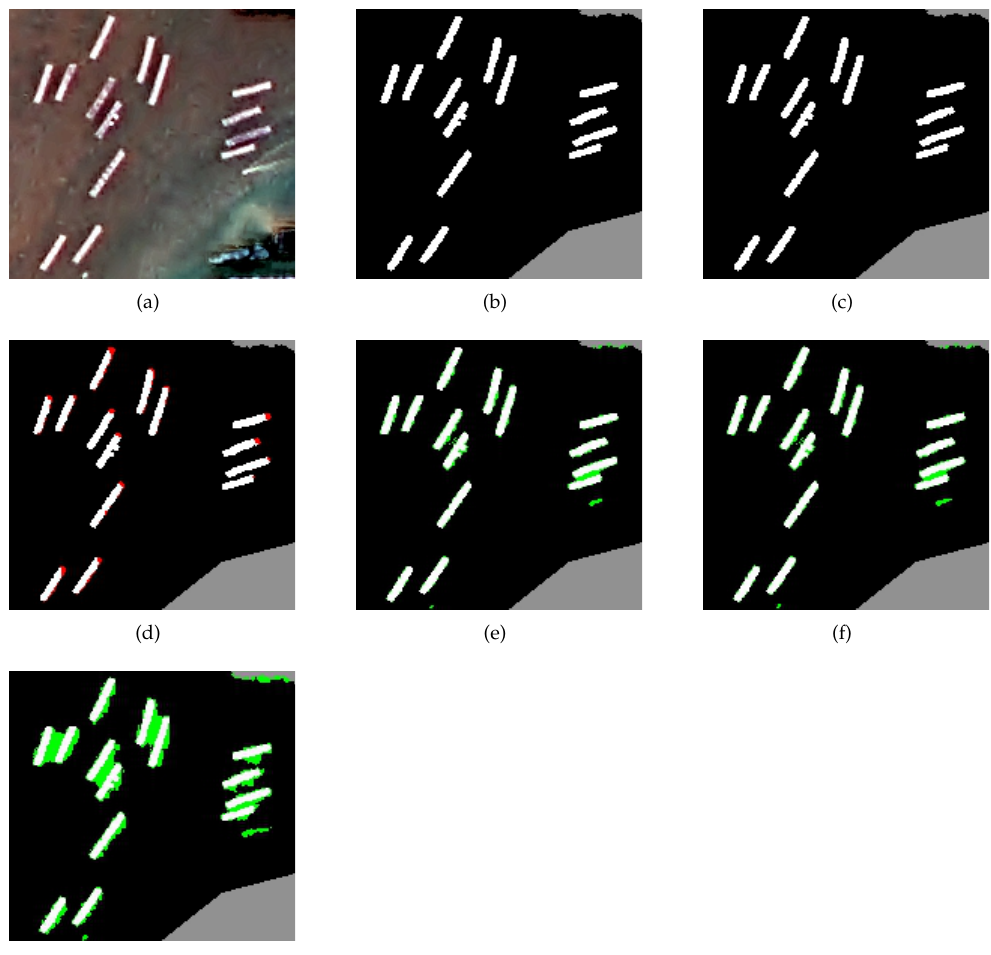
Figure 6. The details of the results of aquatic product extraction by different methods in Region b, with a black color denoting the background, white color denoting the aquaculture raft, red color denoting the missing extraction, and green color denoting more extraction. ( a ) Original image. ( b ) Ground truth image. ( c ) IEGD. ( d ) CEM. ( e ) NN. ( f ) SVM. ( g )